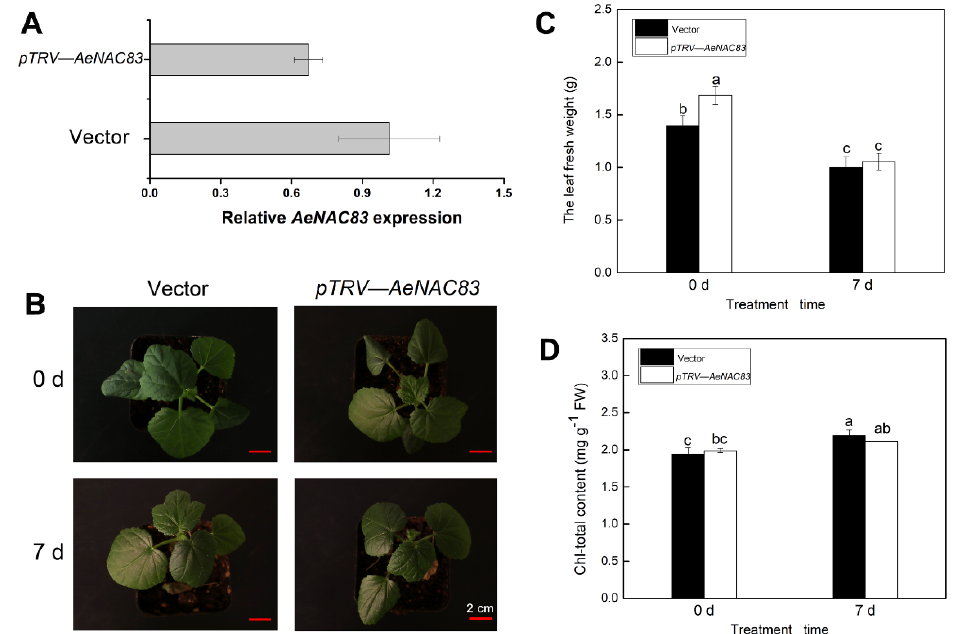
Figure 3. Phenotype analysis of AeNAC83 -silenced okra plants produced by VIGS under salt stress. The Agrobacterium tumefaciens GV3101 cell culture harboring the pTRV2 or AeNAC83 -pTRV2 together with pTRV1 were mixed with a ratio of 1:1 and syringe-infiltrated into okra cotyledons. At 25 d post-inoculation (dpi), the leaves were used for gene expression assay and 300 mM NaCl treatment for 7 days. ( A ) Expression analysis of AeNAC83 in AeNAC83 -silenced okra seedlings by qRT-PCR. ( B ) Images of plant phenotype. ( C ) The leaf fresh weight. ( D ) Total chlorophyll content. Data are presented as mean ± SD ( n = 10). Different letters denote significant differences at p < 0.05, using ANOVA and Duncan’s multiple